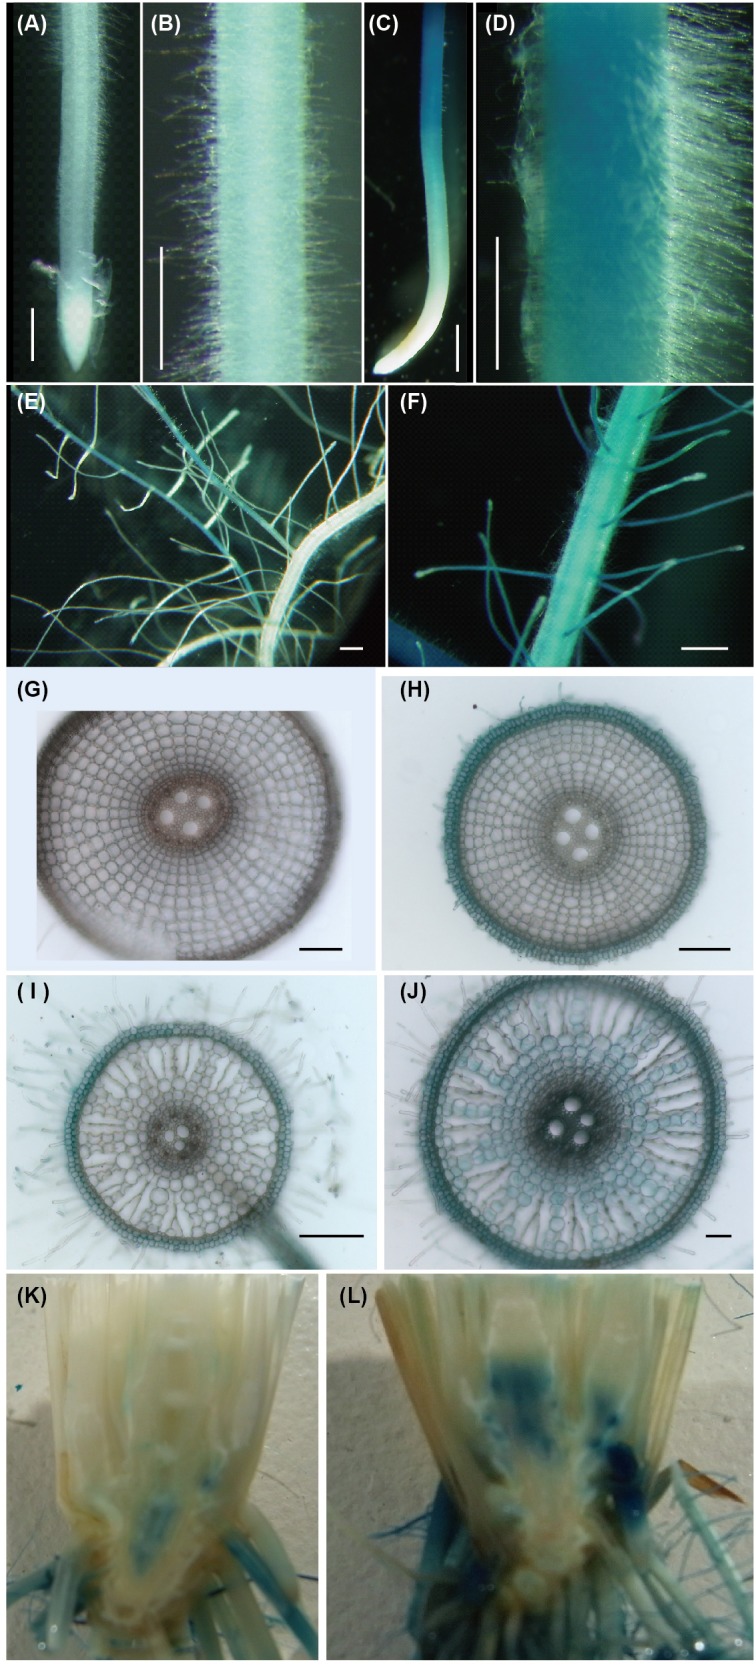
Promoter activity of ENA1 in rice during vegetative growth as indicated by GUS staining. (A,B,E,G,I) Iron (Fe)-sufficient root. (C,D,F,H,I) Fe-deficient root. (G,H) Cross-sections of the elongation zone. (I,J) Cross-sections of the root near the basal part. (K,L) Tissue distribution of ENA1 promoter activity in root–shoot junctions under Fe-sufficient (K) or Fe-deficient (L) conditions. The basal part of the shoot was cut vertically and the interior tissue is shown. Scale bars: 1 mm (A–F); 200 μm (G–J).